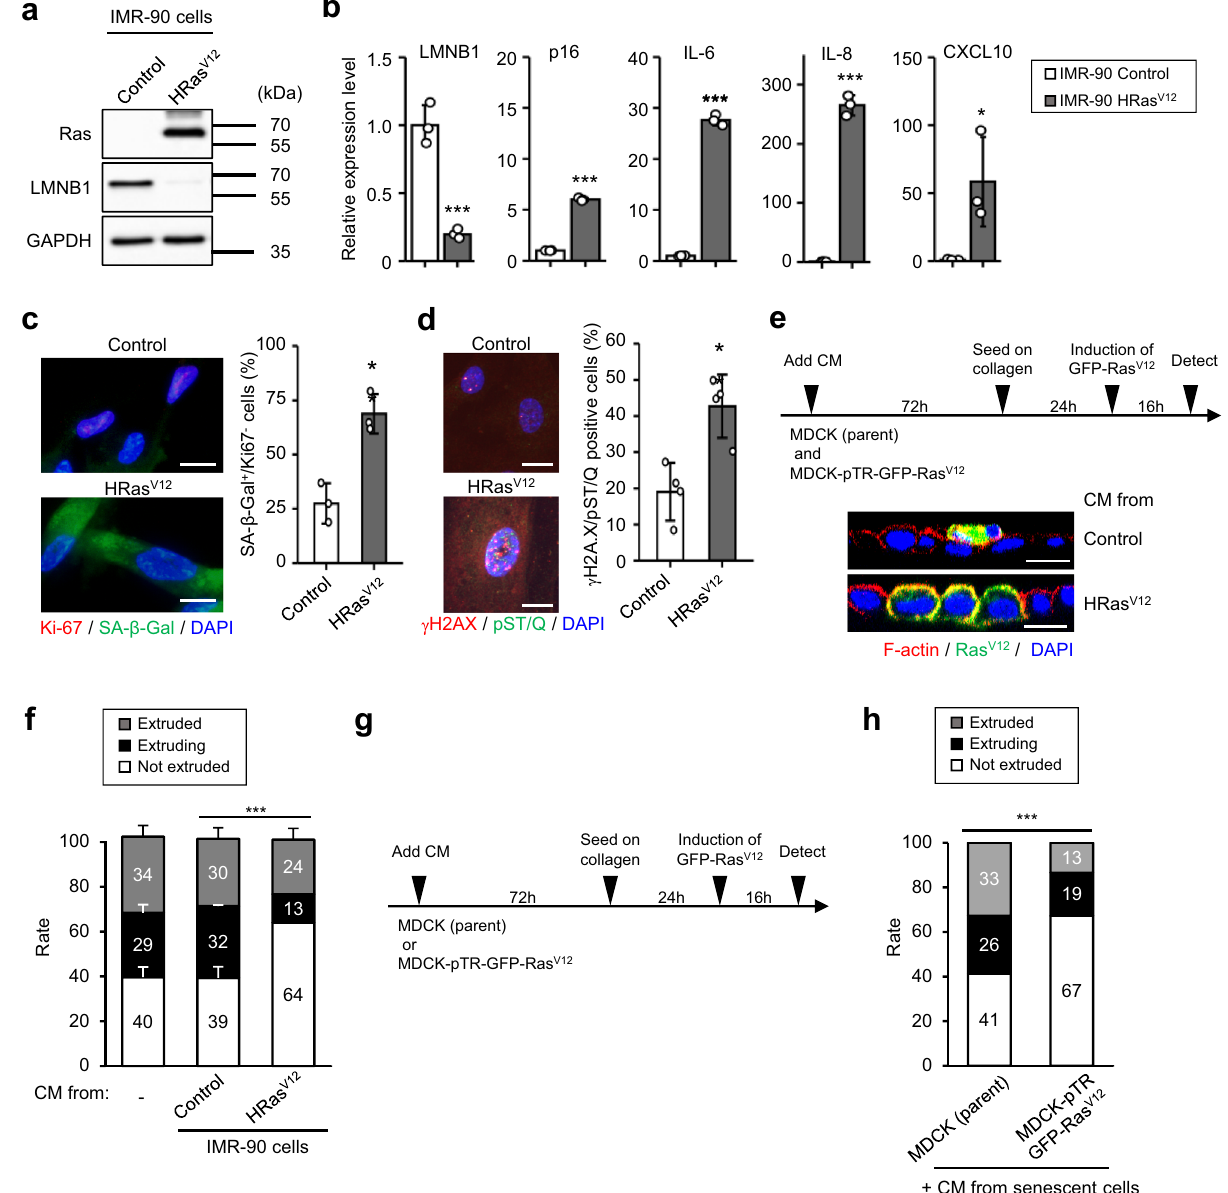
Fig. 1 The secretome from senescent cells suppresses apical extrusion of oncogenic Ras V12 -expressing MDCK cells from the surrounding normal epithelium. a – c Presenescent IMR-90 cells were rendered senescent by ectopic expression of oncogenic ras (H-Ras V12 ). These cells were then subjected to western blotting using antibodies shown toward the left ( a ), RT-qPCR analysis of p16 INK4a and SASP factor gene expression ( b ) (LMNB1, P < 0.001; p16, P < 0.001; IL-6, P < 0.001; IL-8, P < 0.001; CXCL10, P = 0.039), or immuno fl uorescence staining for markers of senescent cell cycle arrest (Ki-67 (red), SA- β -gal (green) and DAPI (blue), P = 0.007) ( c ) and DNA damage ( γ -H2AX (red), phosphor-Ser/Thr ATM/ATR (pST/Q) substrate (green) and DAPI (blue), P = 0.005) ( d ). The blotting experiments have performed at least two times ( a ). Representative data from three independent experiments are shown ( b – d ). The histograms indicate the percentage of Ki-67-negative and SA- β -gal-positive cells ( c ) and nuclei containing more than three foci positive for γ -H2AX and pST/Q staining. At least 100 cells were scored per group ( c , d ). Scale bar, 10 μ m. e – h MDCK (parent) and MDCK-pTR GFP-Ras V12 cells were separately treated with CM derived from proliferating, or oncogene-induced senescent IMR-90 cells ( P < 0.001) ( e , f ) or CM derived from oncogene- induced senescent IMR-90 cells ( P < 0.001) ( g , h ) for 3 days. The treated MDCK (parent) and MDCK-pTR GFP-Ras V12 cells were mixed at a ratio of 50:1 and cultured on type-I collagen gels. These MDCK cells were stained with phalloidin (F-actin, red) and DAPI (blue) after 16 h of incubation with tetracycline to induce Ras V12 in MDCK-pTR GFP-Ras V12 cells. Representative confocal images of xz sections of Ras V12 -expressing MDCK cells (green) in a monolayer or normal MDCK cells ( e ). Scale bar, 10 μ m. Quanti fi cation of the apically extruded, extruding,or not extruded MDCK-pTR GFP-Ras V12 cells from a monolayer of MDCK normal cells ( f , h ). Representative data from three independent experiments are shown. Error bars indicate the mean ± standard deviation of three independent measurements for all graphs. * P < 0.05, ** P < 0.01, or *** P < 0.001 by the unpaired two-sided t test ( b – d ) or the chi-square test ( f , h